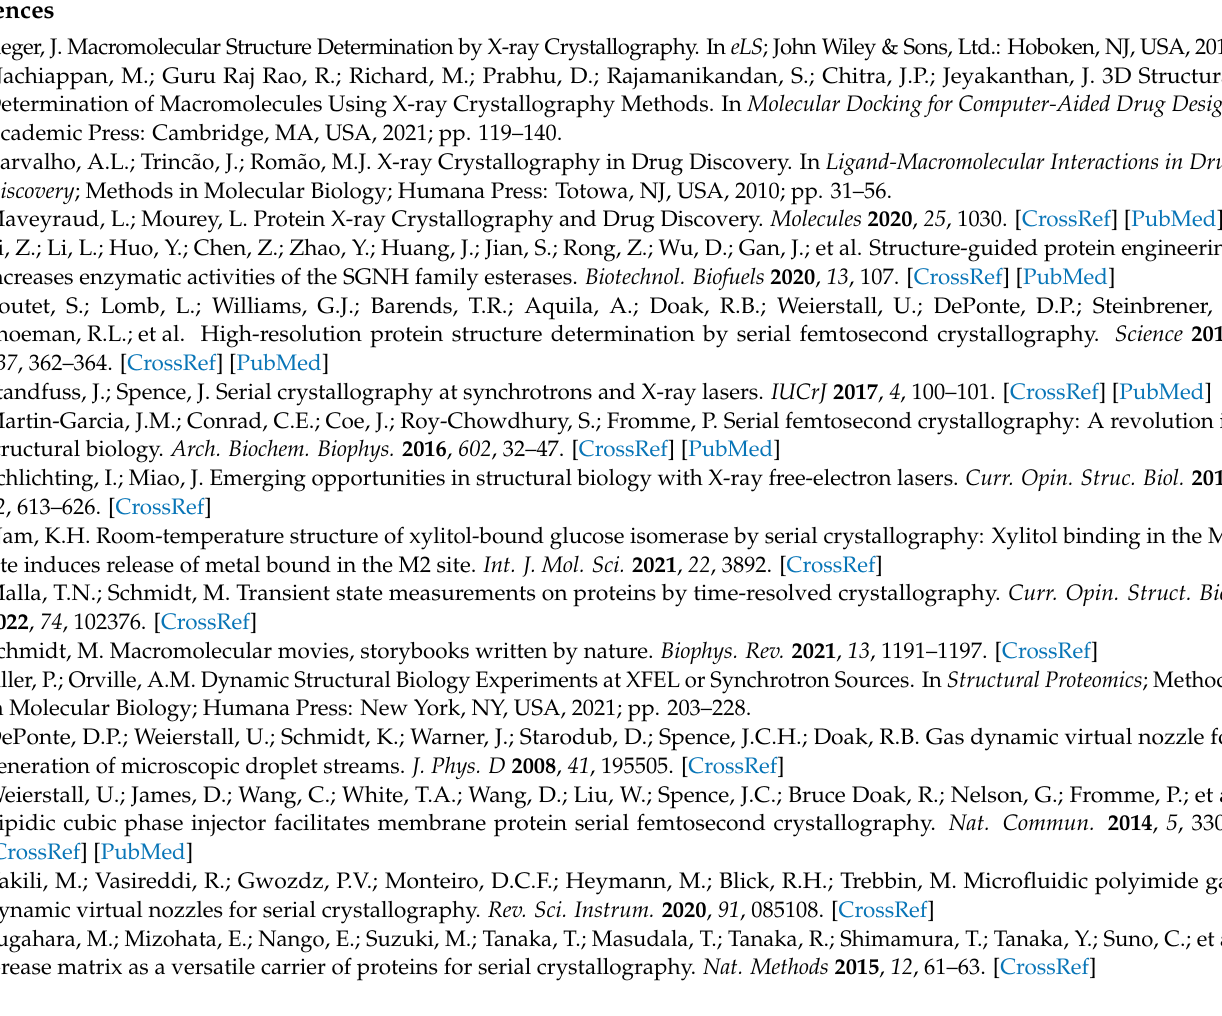
Table S2: Python GUI code for injection needle